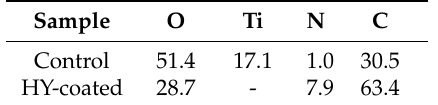
Figure 5. X-ray photoelectron spectroscopy (XPS) wide-scan spectra of control ( a ) and HY-coated ( b ) titanium implant. Table 2. Surface composition (% at.) of Control and HY-coated implants.